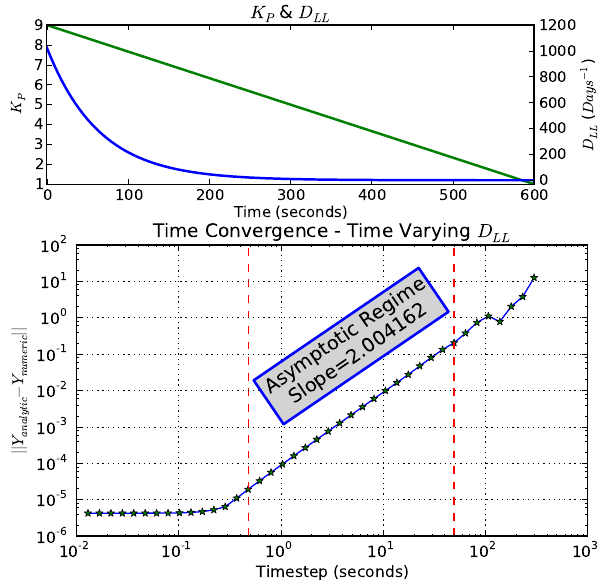
Fig. 8. Results for time verification when using a time-varying D LL . 1L = 0 . 01 for this set. The top frame shows the values of Kp (green line) and BA2000 D LL (blue line). The bottom frame shows the expected convergence of the model in the same manner as the top frame of Fig.